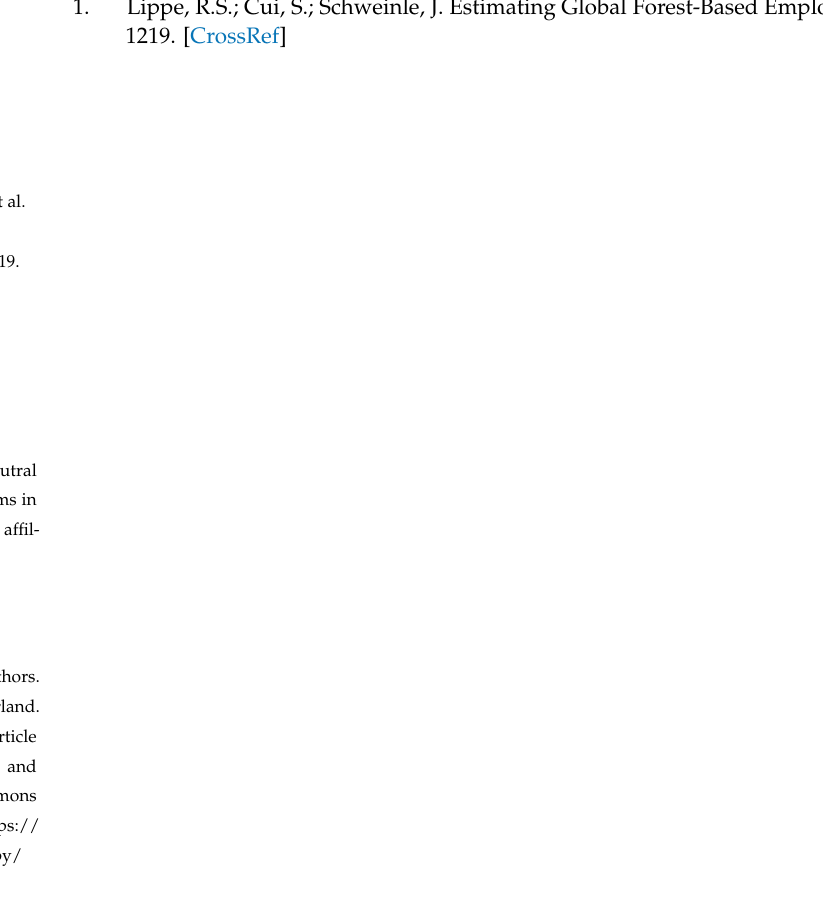
“ Table 5. Comparison our employment estimates (million-person FTE) with the